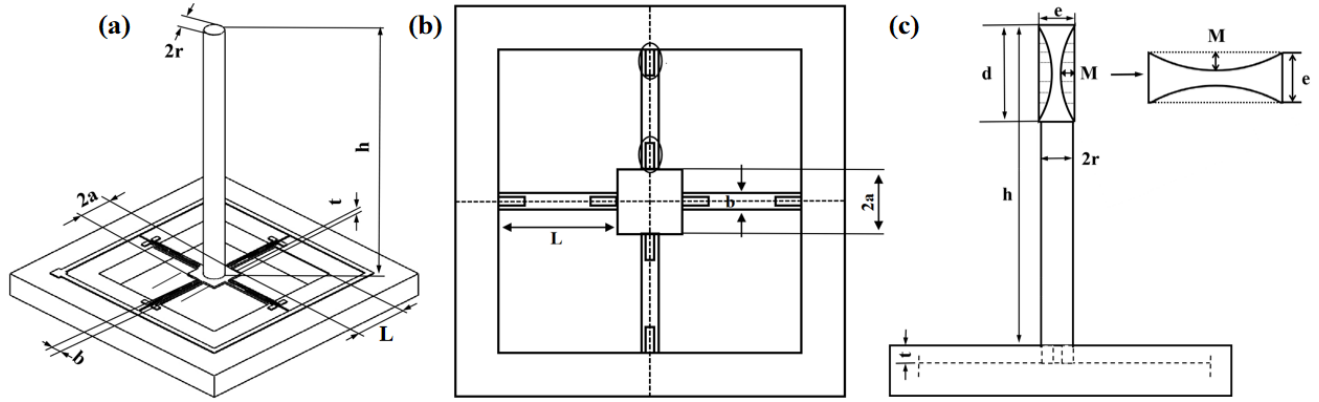
Figure 4. ( a ) Microstructure model for sensor; ( b ) integrated microstructure model of concave cilium; ( c ) microstructure model of concave